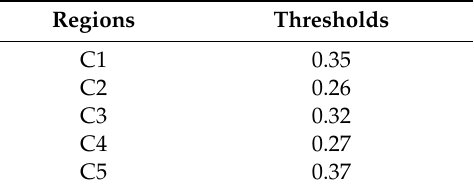
Table 6. The thresholds of the Chinese painting.